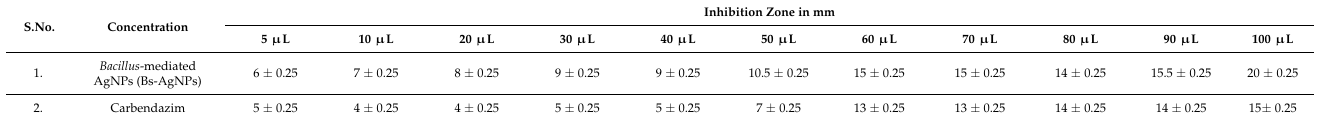
Table 5. Characteristic features of the